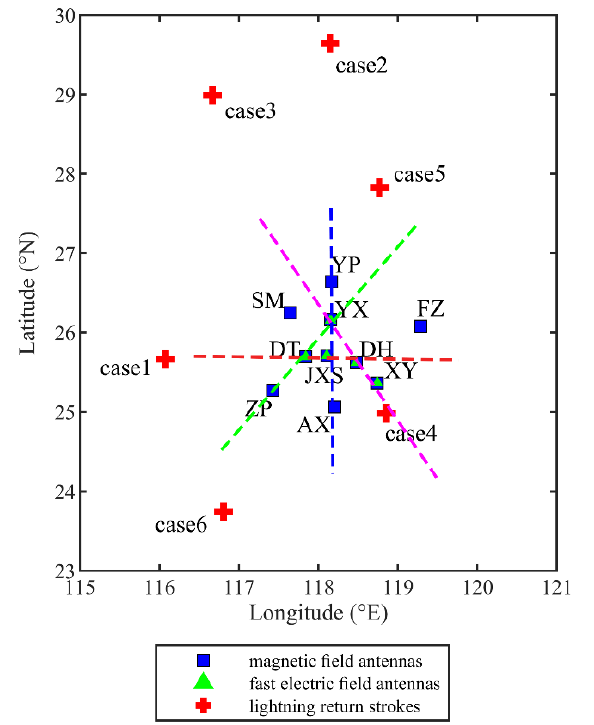
Figure 9. The configuration with three or even four stations lying approximately on a straight line caused the outliers for six cases outside the network. The red line corresponds to the configuration for outliers of case 1. The blue line corresponds to the configuration for outliers of case 2 and case 5. The magenta line corresponds to the configuration for outliers of case 3 and case 4. The green line corresponds to the configuration for outliers of case 6.